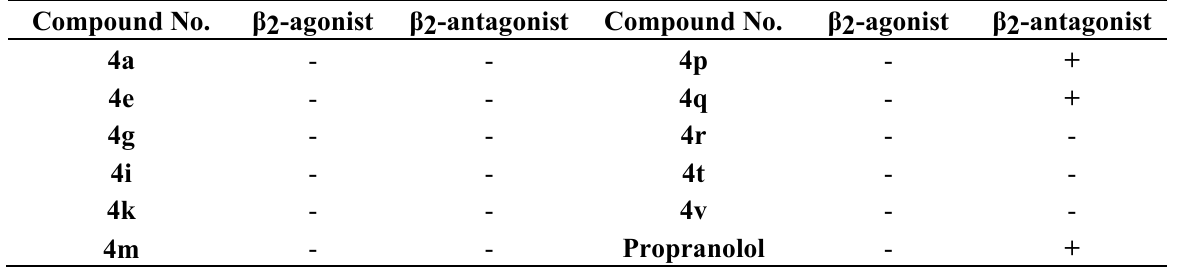
Table 5. β -Adrenergic activities of the tested 2